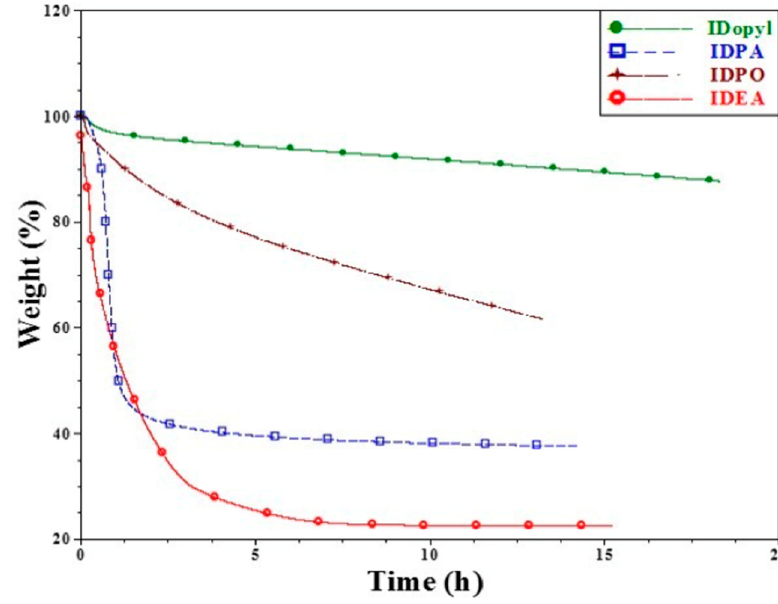
Figure 4. Degradation of Isosorbide bis -Phosphorus Esters at 200 ◦